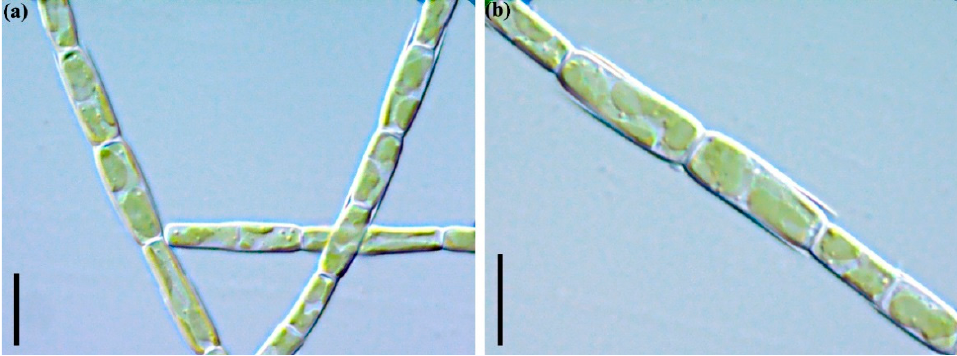
Figure 4. Desmodesmus. armatus (Chodat) Hegewald. Strain ARC06. Coenobia with different num ‐ ber of cells ( a , b ). Scale bars: 10 μ m.